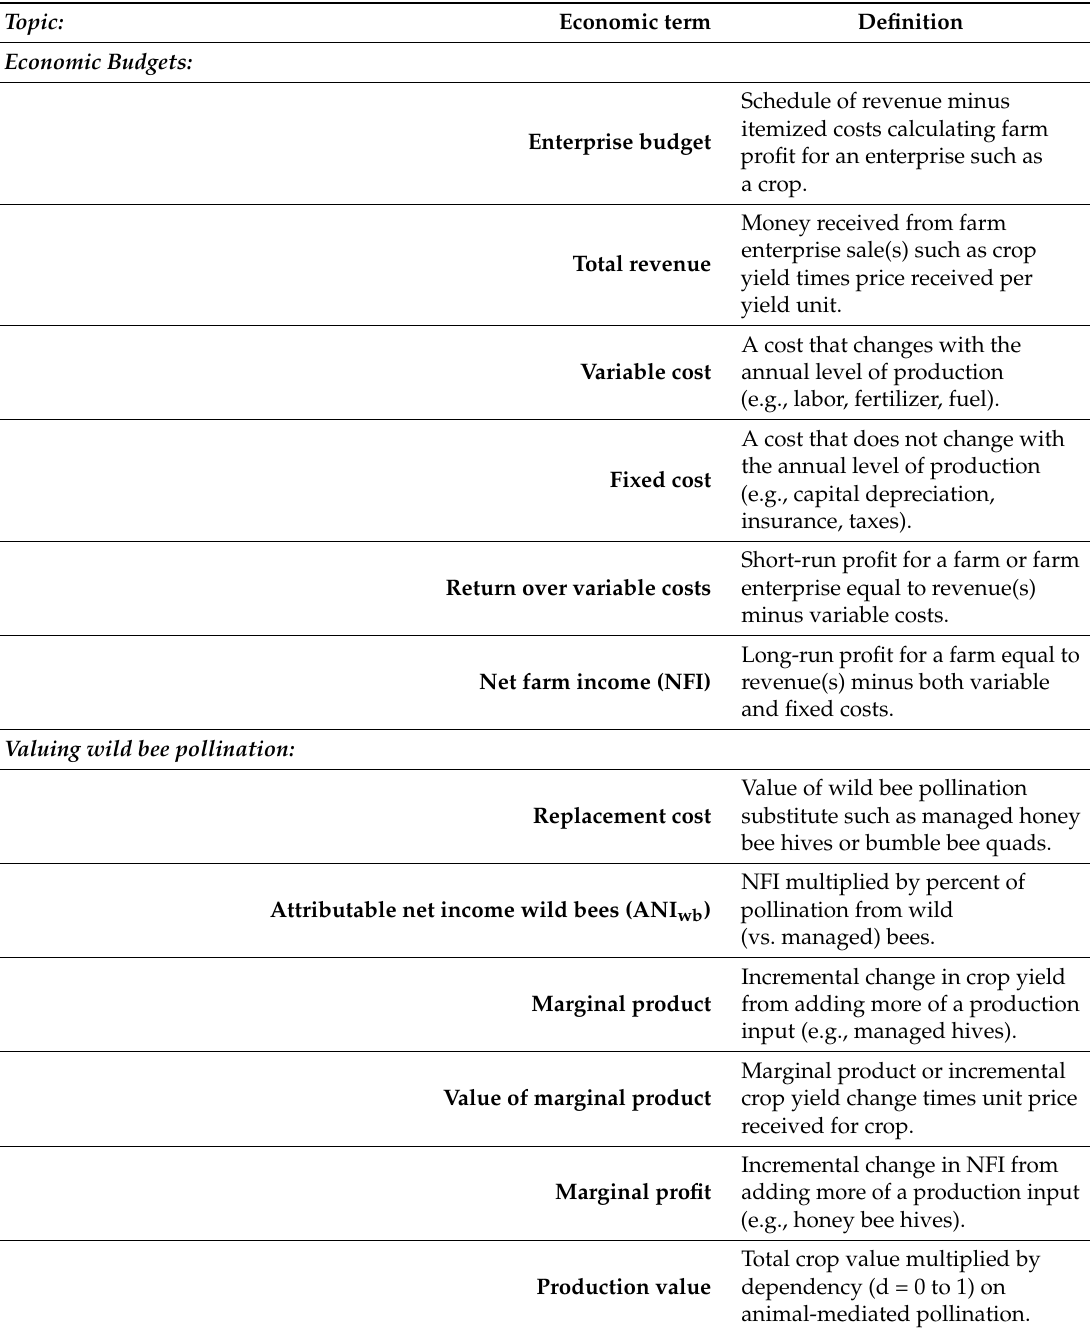
Table 1. Glossary of key economic terms for economic budgeting and valuing wild bee